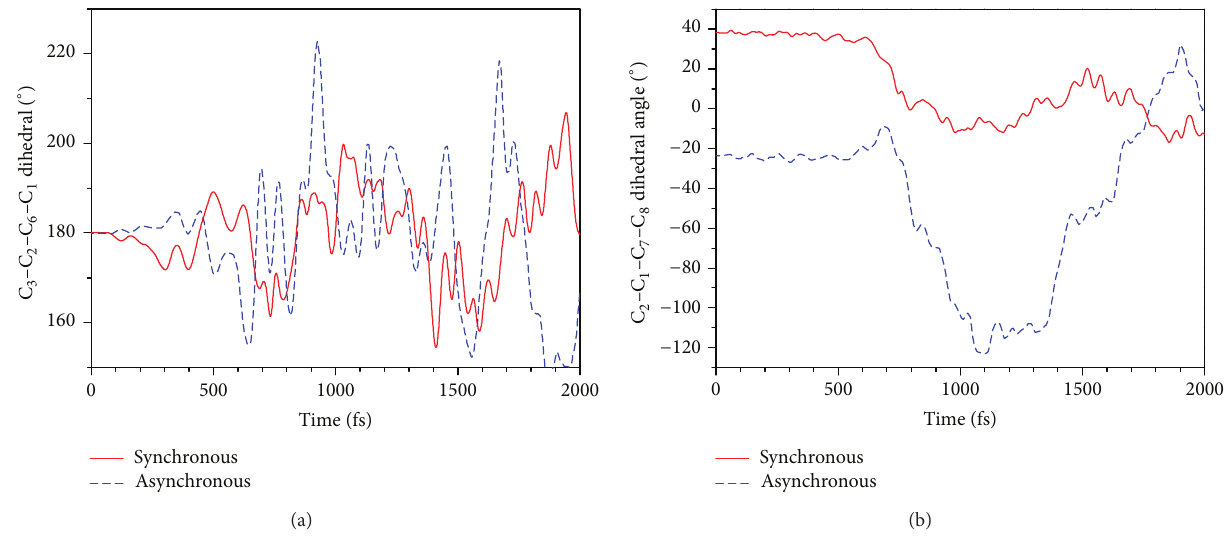
Figure 7: The variations of dihedral angles (a) C 3 –C 2 –C 6 –C 1 and (b) C 2 –C 1 –C 7 –C 8 with time for each mode.